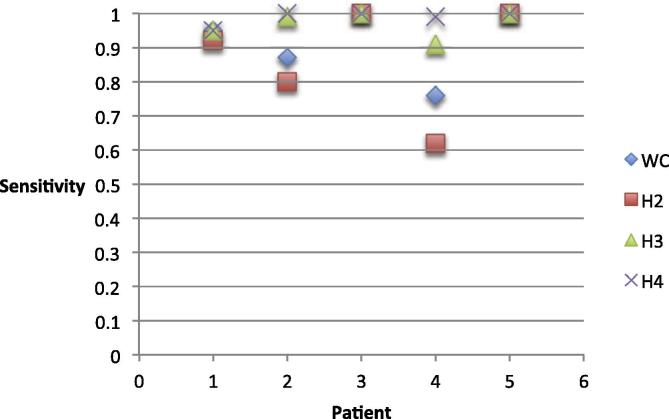
Sensitivity of IED marking of WC and H2, H3 and H4 for all 5 patients.